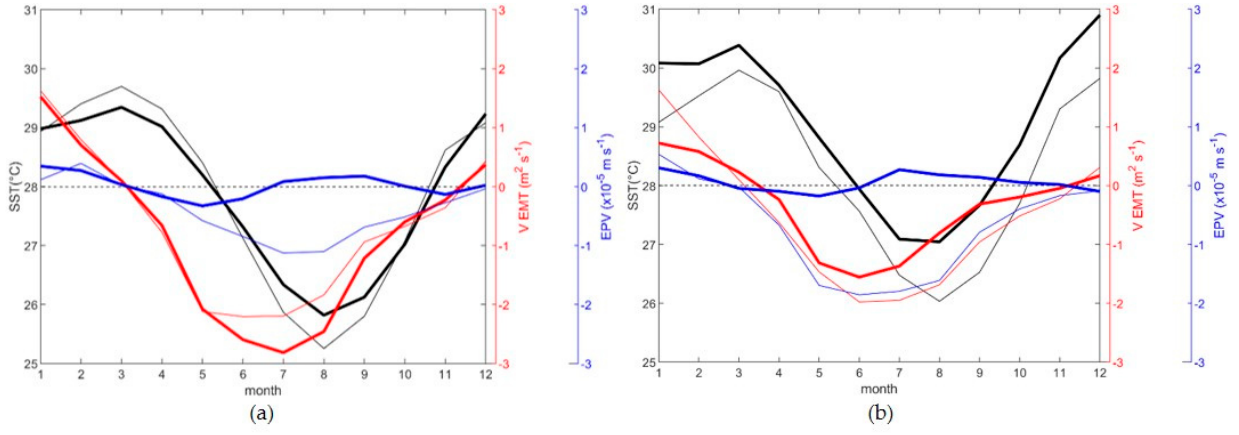
Figure 10. The climatological mean values of sea surface temperature (SST) (black), Ekman Mass Transport (EMT) meridional component (red), and Ekman Pumping Velocity (EPV) (blue). Thin and thick lines denote the mean value in ( a ) Box 1 and Box 2; ( b ) Box 3 and Box 4, respectively. The maximum difference of the EPV ( − 1.253 × 10 − 5 ms − 1 ) also occurs in August be- tween Box 1 and Box 2. EPV becomes positive in Box 2 during the southeast monsoon